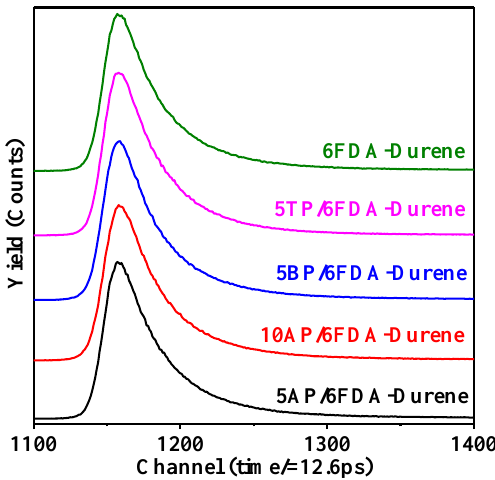
Figure 7. PALS of 6FDA-Durene and “all polyimide” MMMs. It is useful to further modify the gas separation performance of 6FDA-Durene be- cause its CO 2 /CH 4 separation performance exceeds the 1991 Robeson upper bound. As shown in Figure 8, after incorporating microporous PIs into matrix, 5AP/6FDA-Durene, 5BP/6FDA-Durene, and 5TP/6FDA-Durene can improve P CO significantly, which makes 2 the CO 2 /CH 4 separation performance close to the 2008 upper bound limit (Figure 8a). CO 2 /N 2 (Figure 8b), O 2 /N 2 (Figure 8c), and H 2 /CH 4 (Figure 8d) separation performance were also improved. Especially, the performance of 5AP/6FDA-Durene and 5BP/6FDA- Durene in H 2 /CH 4 separation surpasses the 2008 upper bound limit. The ratio of the initial slopes of the CO 2 and CH 4 adsorption isotherm in Henry’s law region was used to calculated the Henry adsorption selectivity [62] (Figure S12 and Table S3 in supplemen- tary material). Selectivity of CO 2 /CH 4 for AP was 4.02. According to the estimation of Maxwell’s equations, with the increase of filler content, the gas separation performance of the composite membrane will change from the matrix to the filler. The CO 2 permeability coefficient of AP is assumed to be very large. The slightly decrease of CO 2 /CH 4 selectiv- ity of “all polyimide” MMMs compared to 6FDA-Durene is fitted for the estimation of Maxwell’s equations. It can explain that, although AP has many ultra-fine micropores less than 1 nm in NLDFT pore size distribution (Figure 2b), MMMs with AP loading do not display molecular sieving performance for gas molecules with smaller dynamic diame- ter [54]. Despite the low Henry adsorption selectivity of microporous PIs, the membrane separation selectivity is not greatly lost, in fact, due to the good two-phase compatibility in “all polyimide” MMMs. In addition, the increase of CO 2 permeation of 5AP/6FDA-Durene after modification is fitted to the estimation of Maxwell’s equations [21,39]. The blockage of the pores in dispersed phase of 10AP/6FDA-Durene makes it deviate from Maxwell’s equation model. Therefore, low filling content (5 wt.%) can significantly increase gas permeation in “all polyimide”